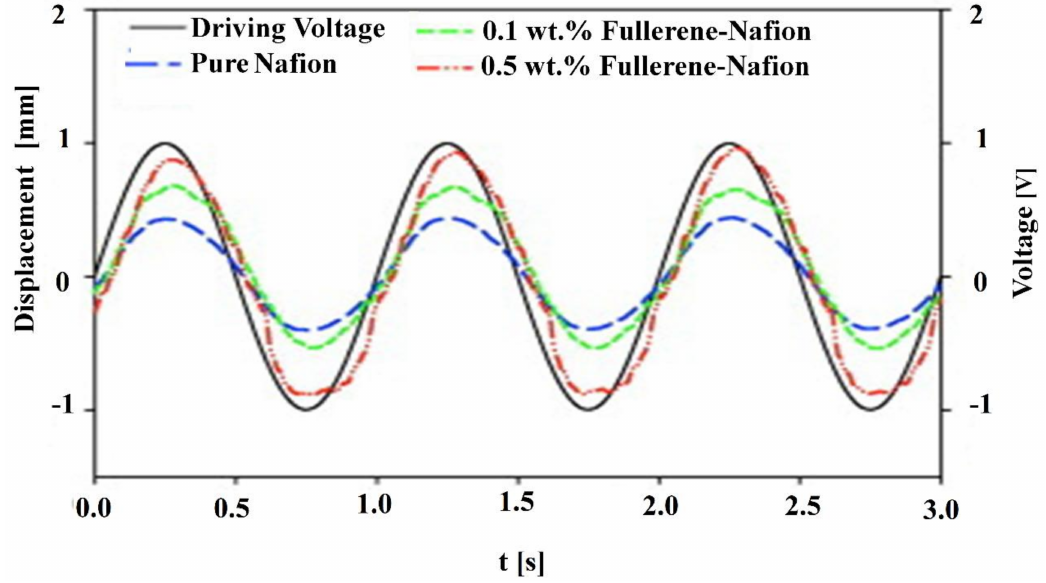
Figure 6. Displacement of fullerene-based actuators in function of 1 V driving voltage